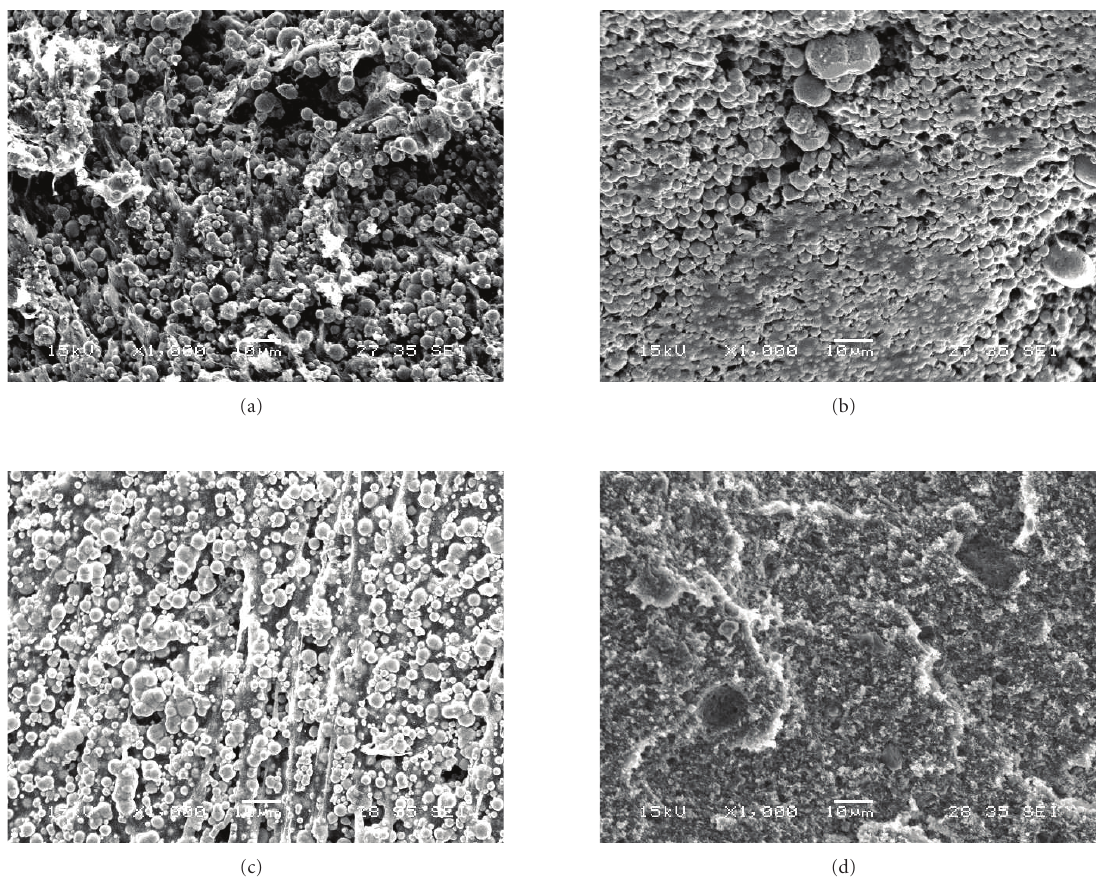
Figure 13: SEM micrographs of the end sections of samples with unresolved binder that are pressed into zigzag mould; (a) Fe − 2Ni, (b) FN02, (c) 316L, (d)